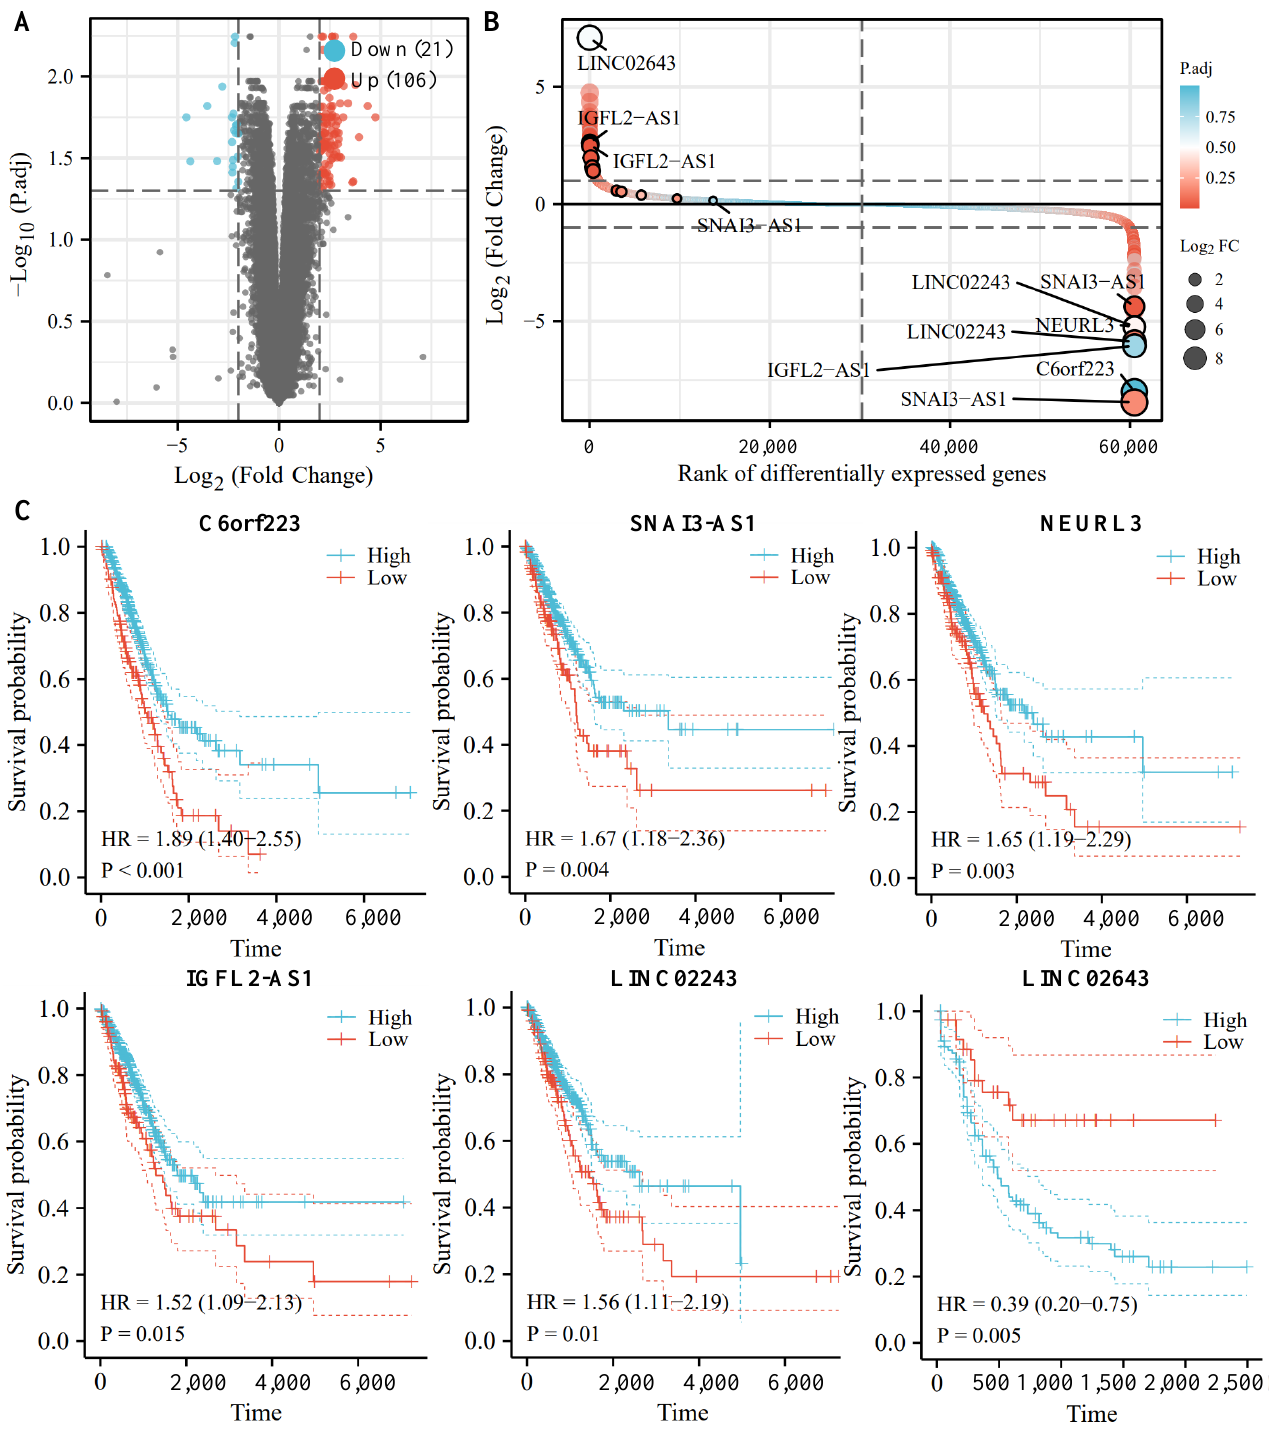
Figure 9. Identification and analysis of lncRNAs from TCGA and GEO database. ( A ) Volcano plot shows the profile of differentially expressed lncRNAs between the healthy volunteers and NSCLC patients from TCGA and GEO databases. ( B ) LINC02643, LINC02243, IGFL2-AS1, NEURL3, SNAI3-AS1, and C6or223 are screened by robust rank aggregation. ( C ) The KM plots of